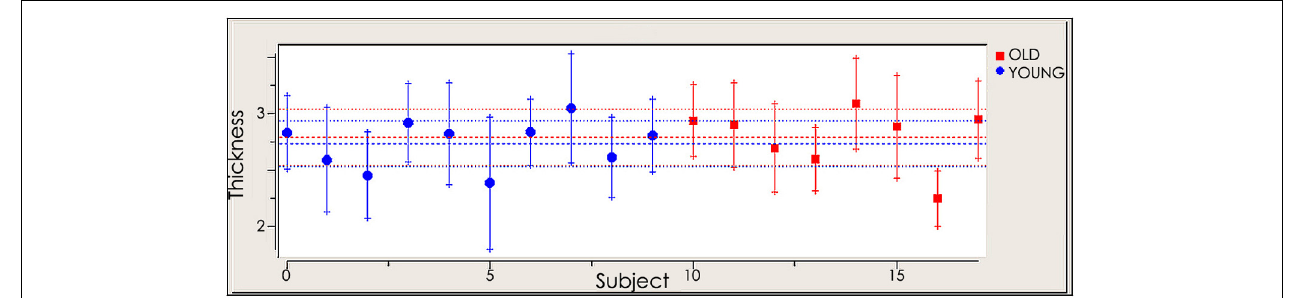
FIGURE 3 | Cortical thickness of selected region of interest (ROI) in young and old cohort.